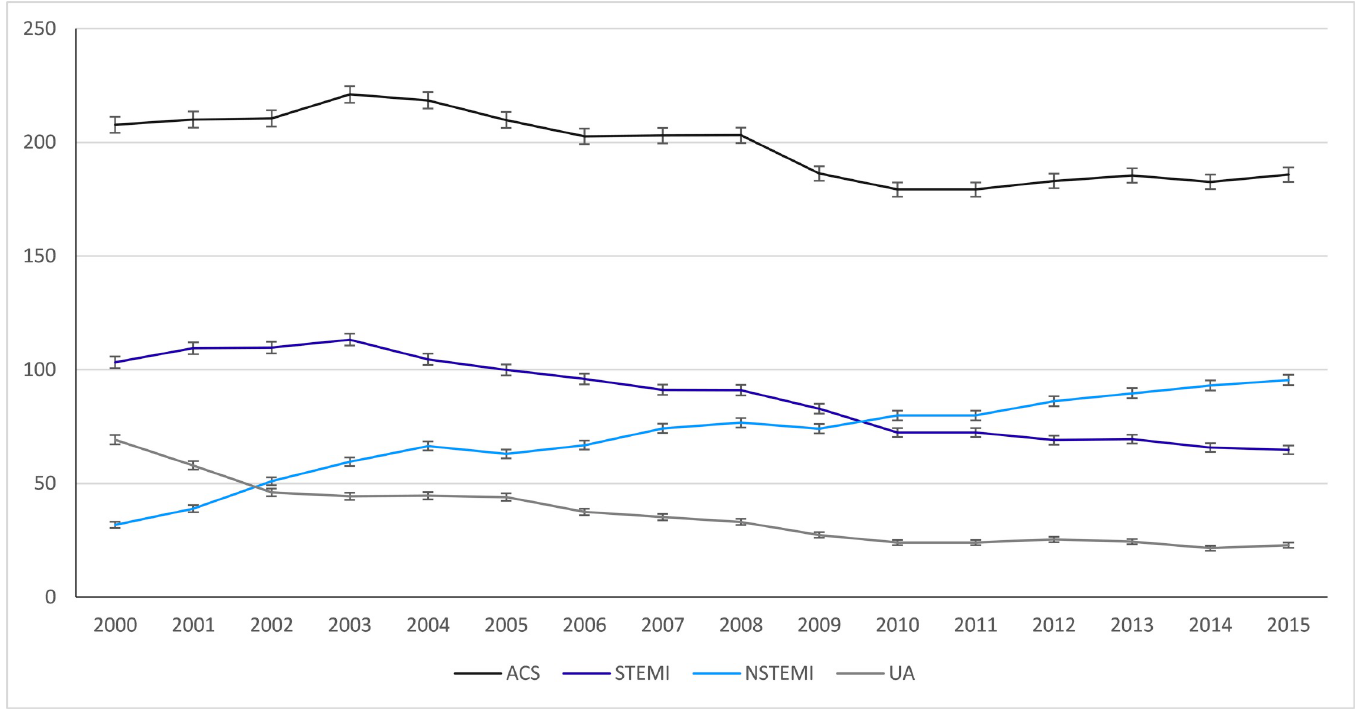
Fig 2. Age-sex standardized ACS-EC hospitalization rate between 2000–2015, per 100,000 person-years.